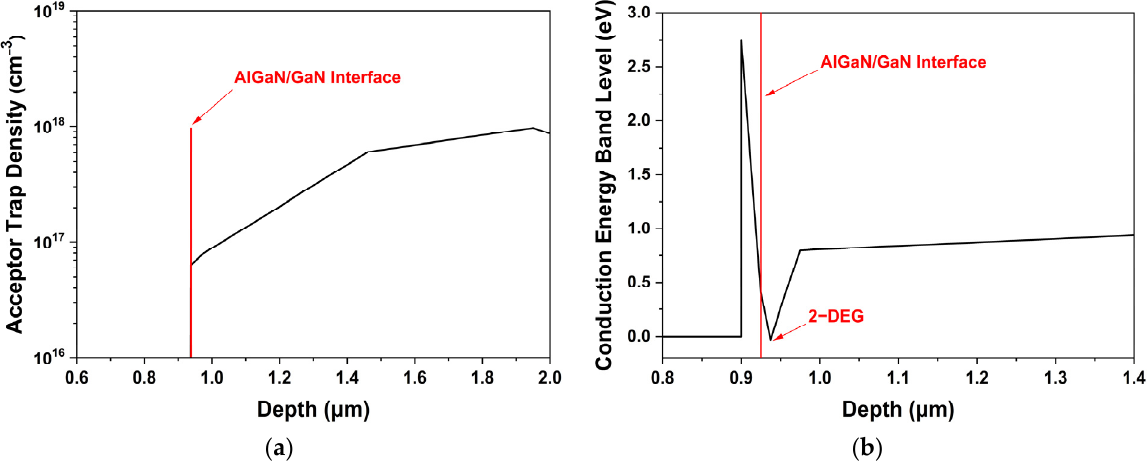
Figure 3. ( a ) Acceptor trap doping profile for the GaN buffer layer as a function of depth; ( b ) conduction energy band level of the simulated device as a function of depth.